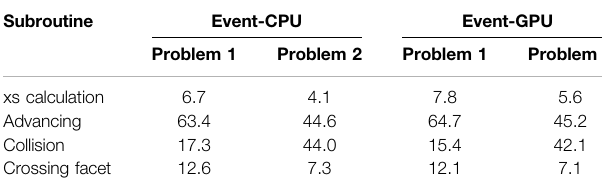
TABLE 4 | Percentage (%) of time spent on subroutines of event-based algorithm on CPU and GPU for problem 1 and problem